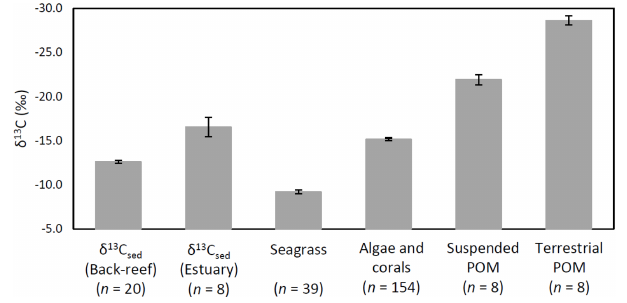
Figure 6. δ 13 C sed at each site and the δ 13 C values of potential sources of OC of δ 13 C sed (means ± SE).